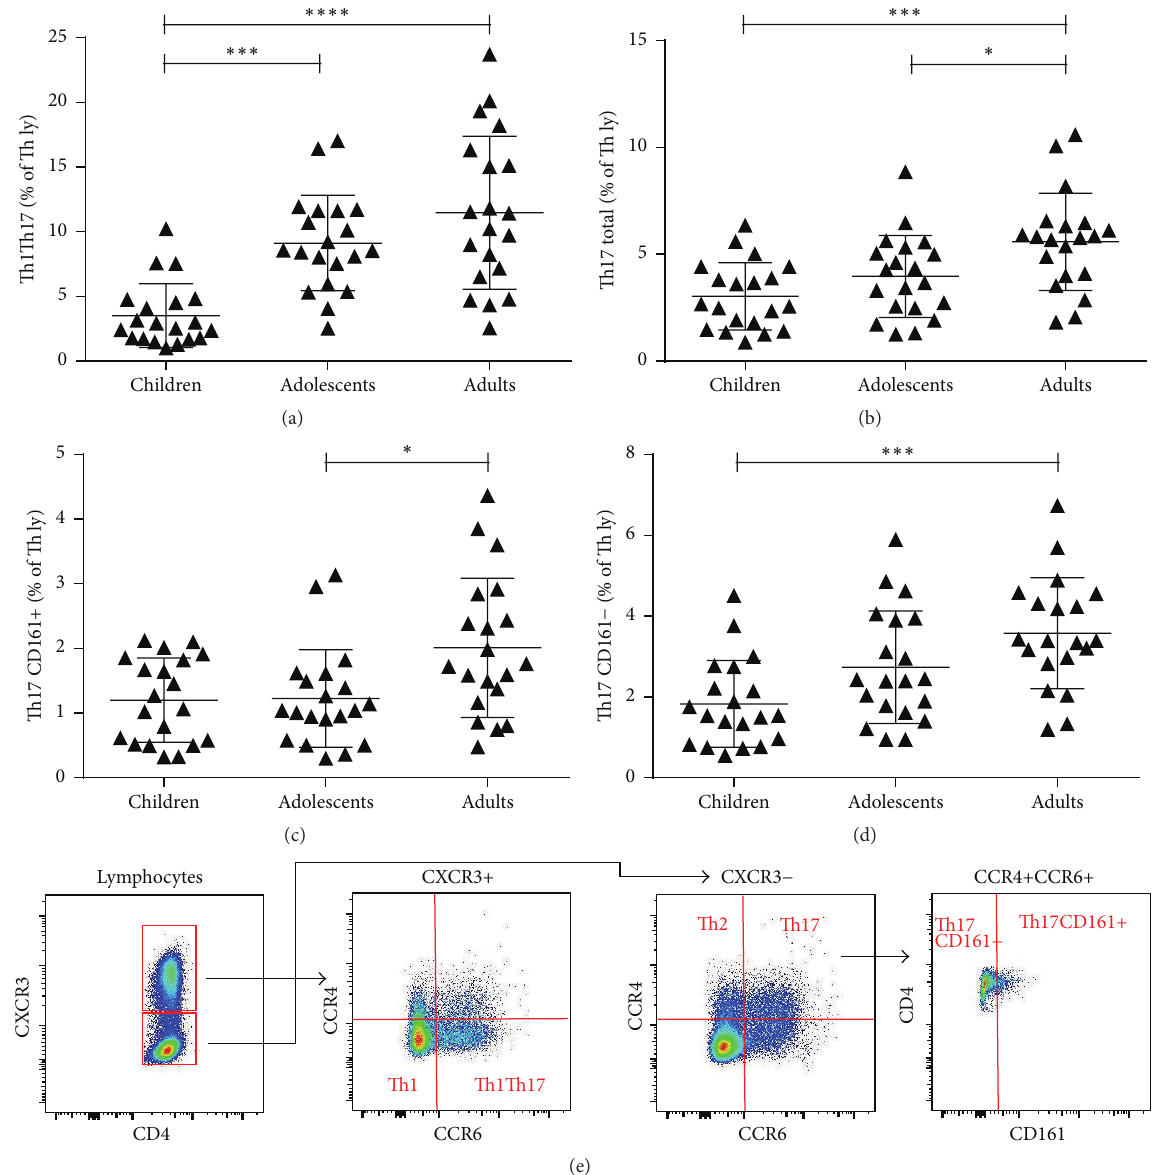
Figure 1: Th17 subset difference among populations. (a) The percentage of Th1Th17 lymphocytes in children was lower than those of adolescents or adults (b). Adult subjects had a higher percentage of total Th17 lymphocytes compared to both children and adolescents. (c) The increase in the percentage of Th17CD161+ lymphocytes in adults was significant compared to adolescents, and (d) the percentage of Th17CD161 − lymphocytes in adults differed significantly from that in children. Each symbol in graphs (a) to (d) represents a single sample. The black lines in graphs (a) to (d) indicate the mean value with standard deviations. ∗ 𝑃 < 0.05 ; ∗∗ 𝑃 < 0.01 ; ∗∗∗ 𝑃 < 0.001 ; ∗∗∗∗ 𝑃 < 0.0001 . (e) Gating strategies and staining patterns for identification of subpopulations Th1, Th2, Th1Th17, Th17CD161+, and Th17CD161 − .